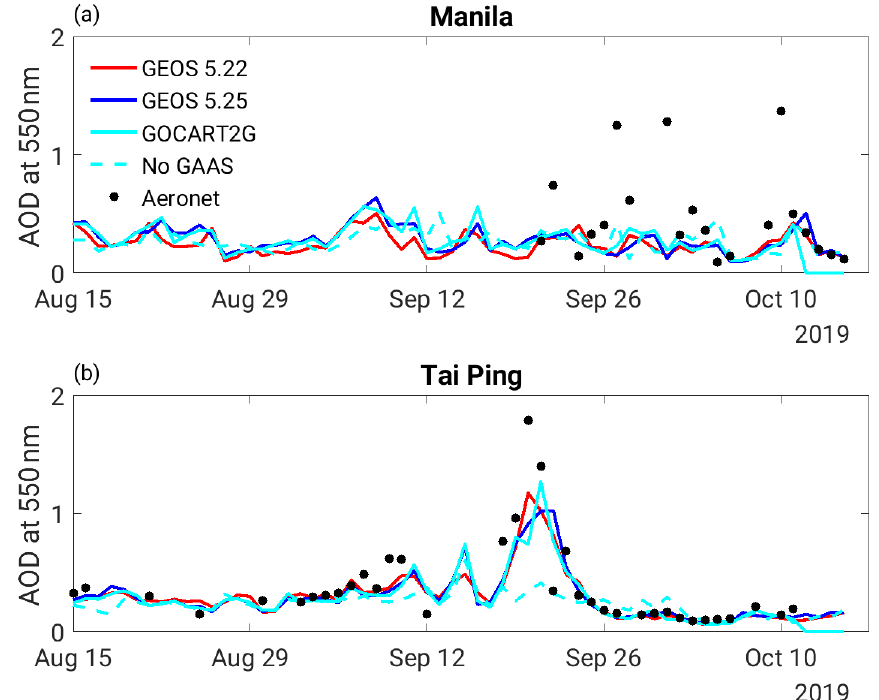
Figure 2. Time series of aerosol optical depth at 550nm from AERONET sites in (a) Manila (Philippines) and (b) Tai Ping Island as well as the corresponding time series from GEOS 5.22, GEOS 5.25, GOCART2G, and GOCART2G without